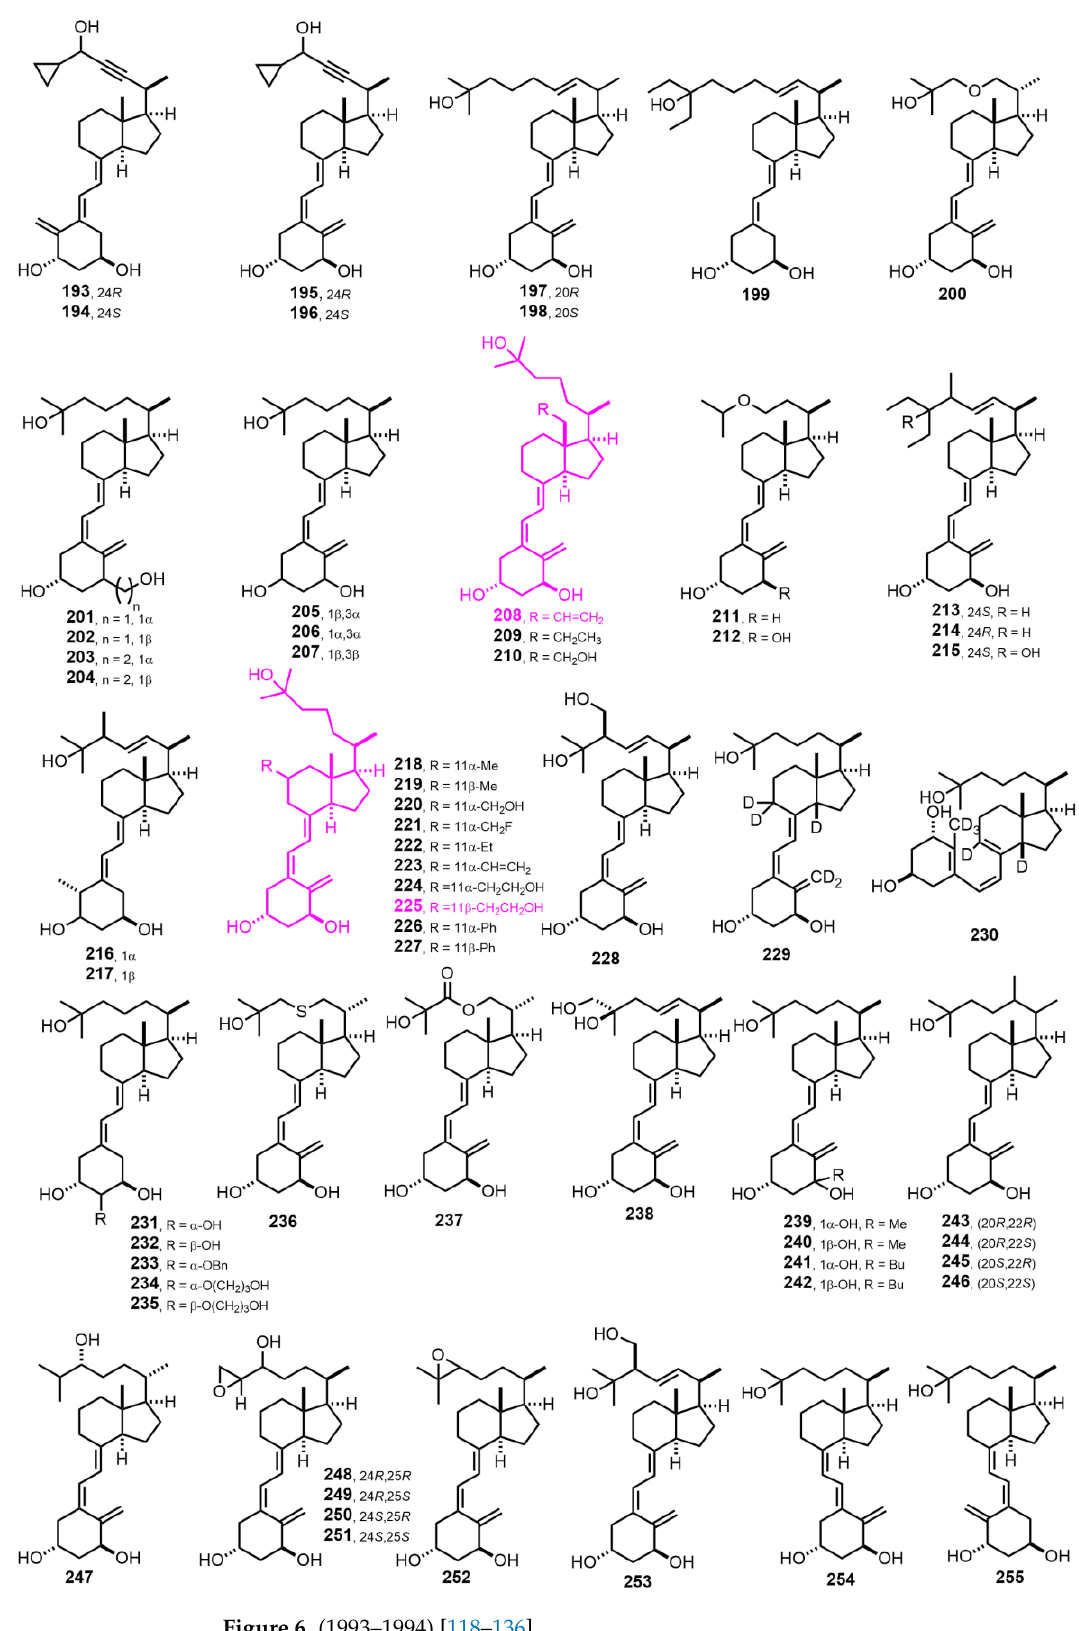
Figure 6. (1993–1994)